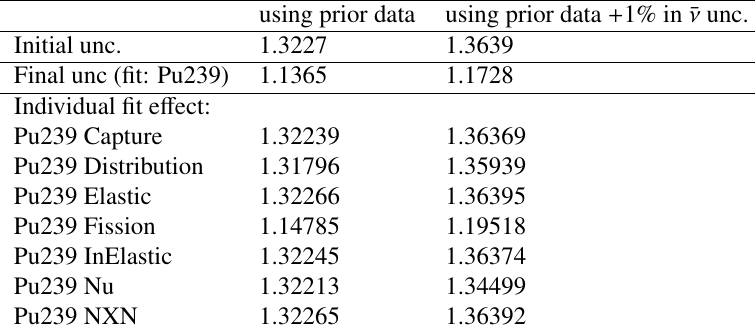
Table 1. k ef f uncertainties for ASTRID using prior data using prior data + 1% in ¯ ν